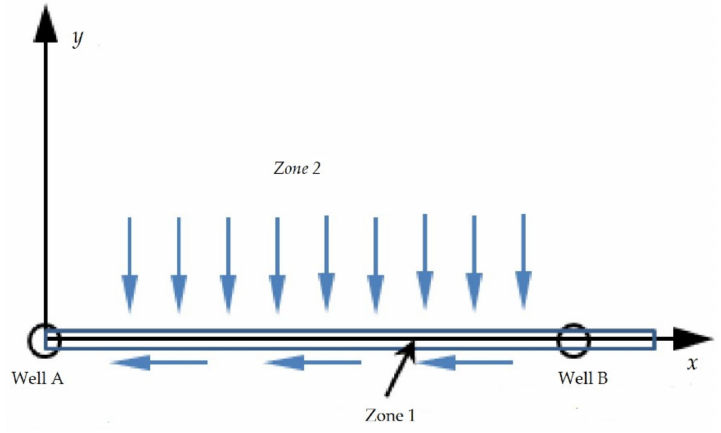
Figure A1. Flow regime of a large fracture with crossflow of the